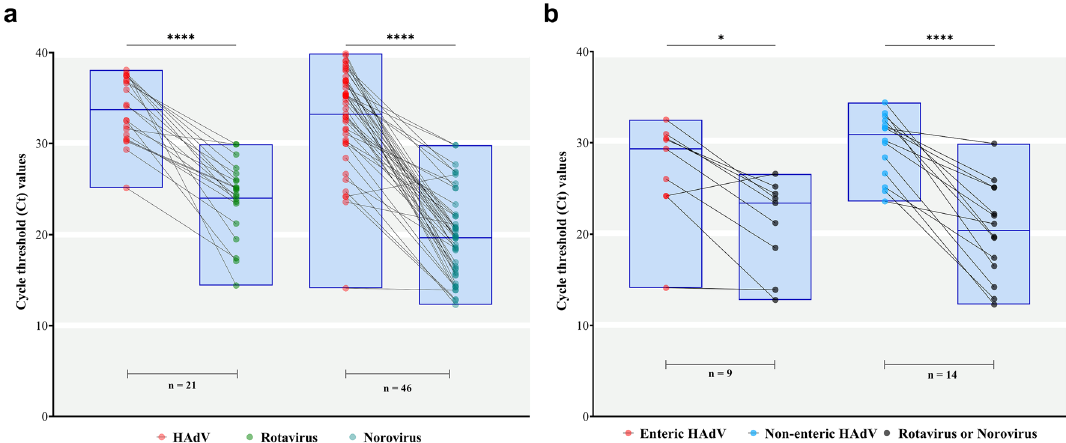
Figure 5. (a) Distribution of Cycle Threshold (Ct) values obtained from qPCR for HAdV and by qRT ‐ PCR for rotavirus and norovirus for each co-detected positive sample. (b) Detailed analyses of the Ct values of each characterized enteric and non-enteric HAdV, detected in co-detections with other enteric viruses (rotavirus or norovirus). Box-and-whisker plots show the first and third quartiles (equivalent to the 5th and 95th percentiles), the median (the horizontal line in the box). * p ≤ 0.05; **** p ≤